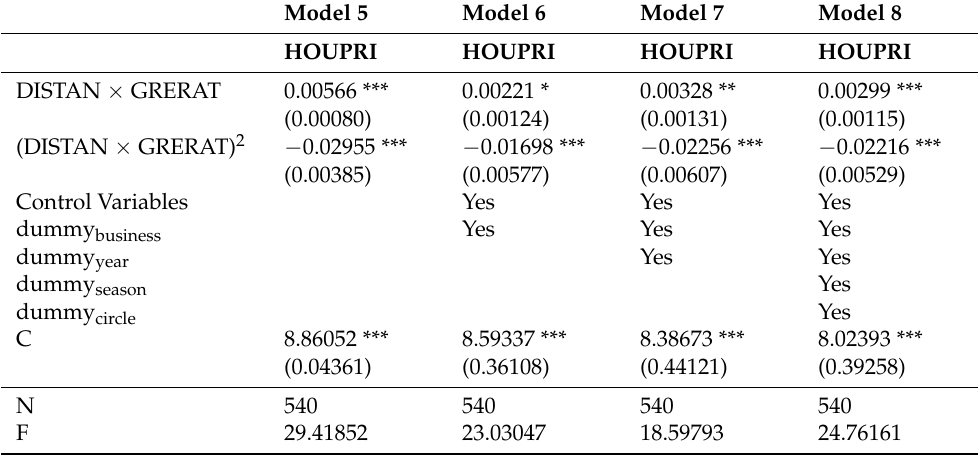
Table 3. The moderating role of the greening ratio before the release of the assessment